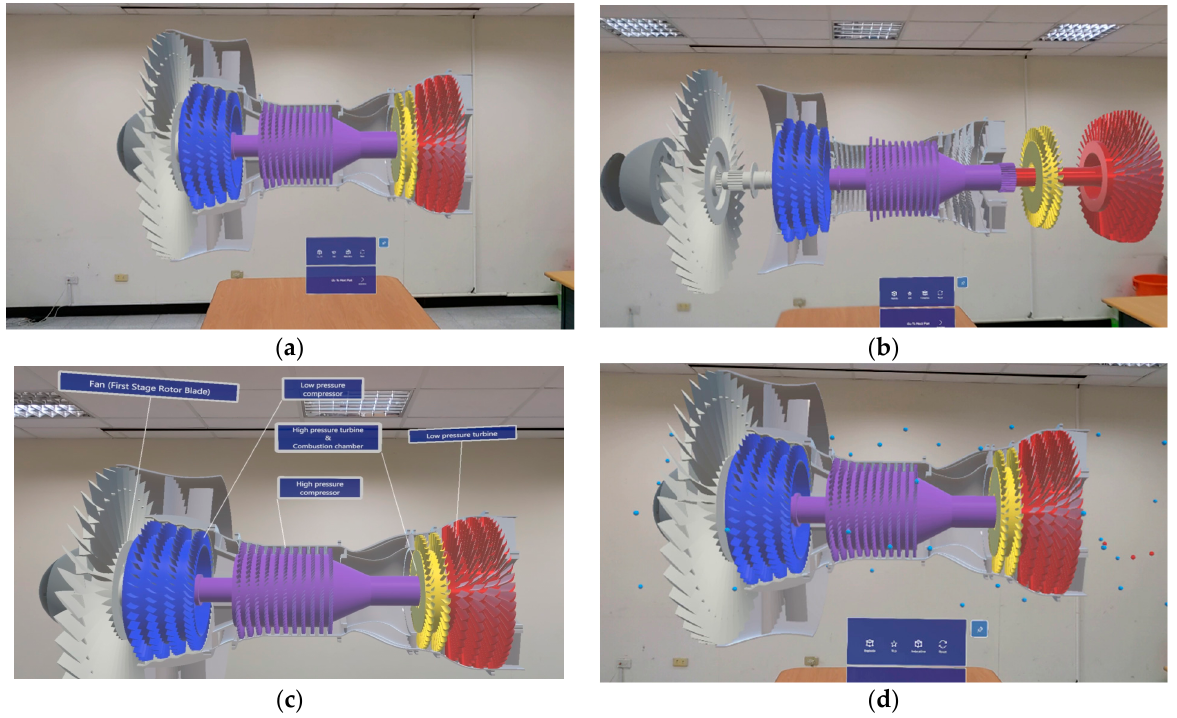
Figure 3. The introduction of the JT9D engine: ( a ) 3D model of the engine; ( b ) An exploded diagram animation of the engine; ( c ) Location of main module of the engine; ( d ) Particle system to simulate the airflow of enigine.